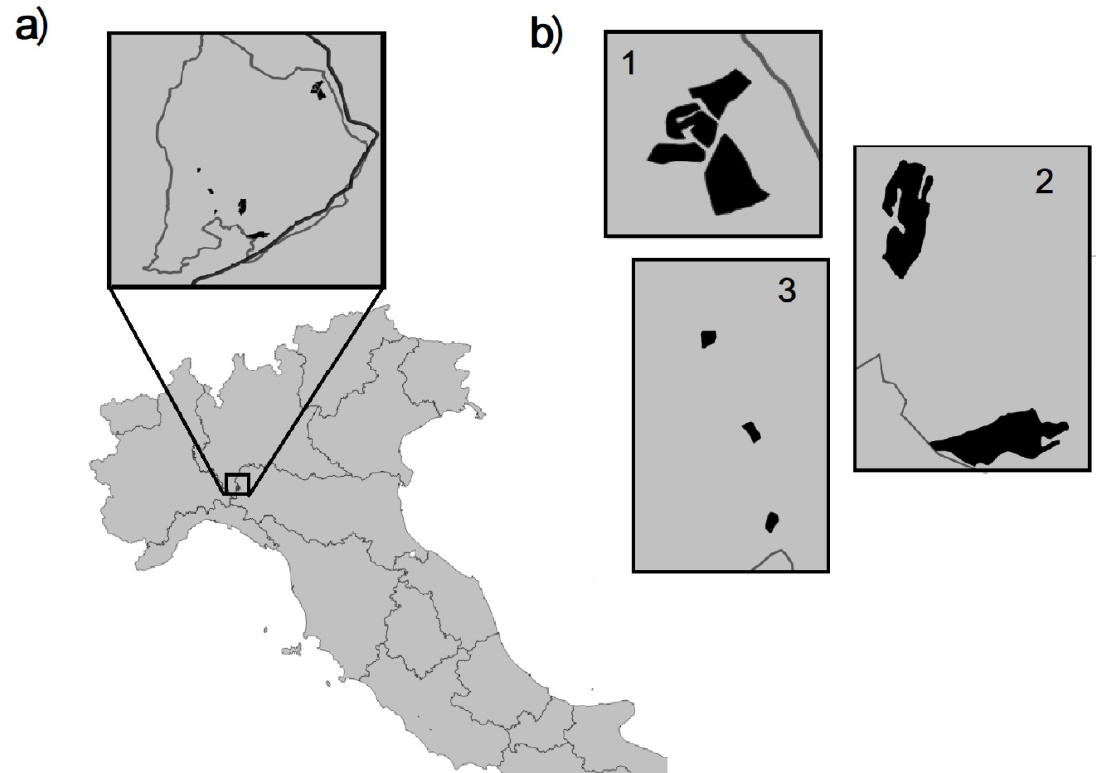
Figure 1. Study area: ( a ) Geographical location of the SCI “Sassi Neri-Pietra Corva” in the Northern Apennines (Lombardy region); ( b ) shape and location of the nine semi-natural grasslands belonging to EU habitat type 6510 within the study area: ( 1 ) 9.53° E, 44.83° N; ( 2 ) 9.34° E, 44.81° N; ( 3 ) 9.33° E, 44.81° N.